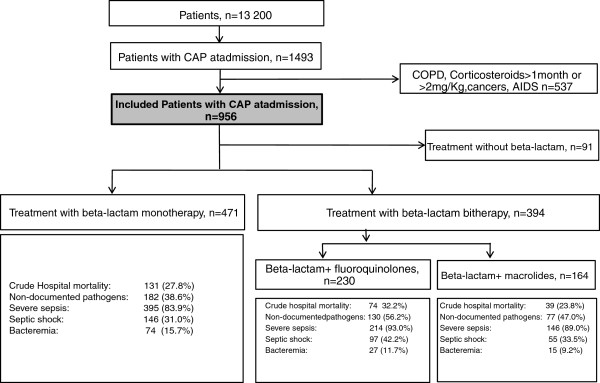
Flow diagram of the patients with community-acquired pneumonia (CAP).